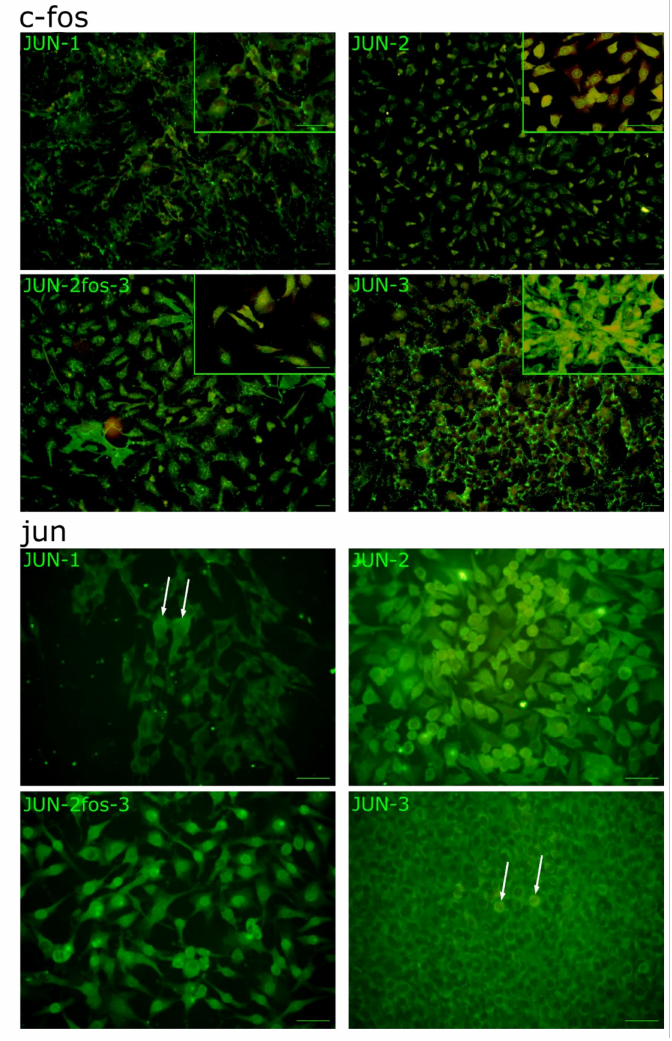
Figure 2. Fos and Jun oncoproteins expression in fibrosarcoma cell lines. Indirect immunofluo- rescence analysis. Notice the high nuclear expression of both oncoproteins in JUN-2 as well as JUN-2fos-3 cells and their low expression levels in JUN-1 cells. Fos seems to be quite highly ex- pressed in JUN-3 cells as well, with an unusual perinuclear localisation. Both JUN-1 and JUN-3 seem to be generally devoid of appreciable nuclear Jun, except some individual scattered cells (arrows). Pictures were taken by Olympus IX70 fluorescent microscope equipped with the Olympus DP71 camera system (Bar: 100 µ m) Negative controls are shown in Figure S2. Table 1. Growth characteristics of the JUN-sarcoma cell